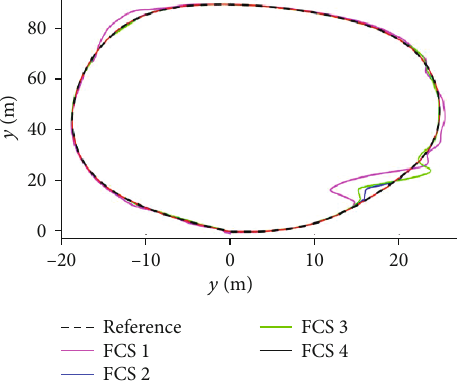
Figure 6: Evolution of the quadrotor ’ s trajectory in 2D ( x − y plane) for di ff erent fl ight control systems: fl ight scenario